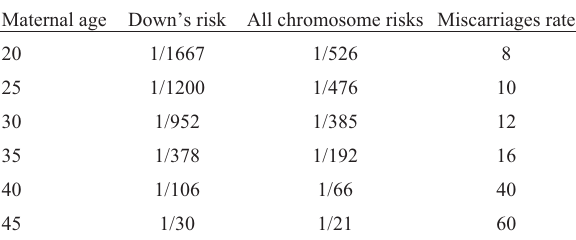
Table 2 - Pregnancy loss rate and maternal